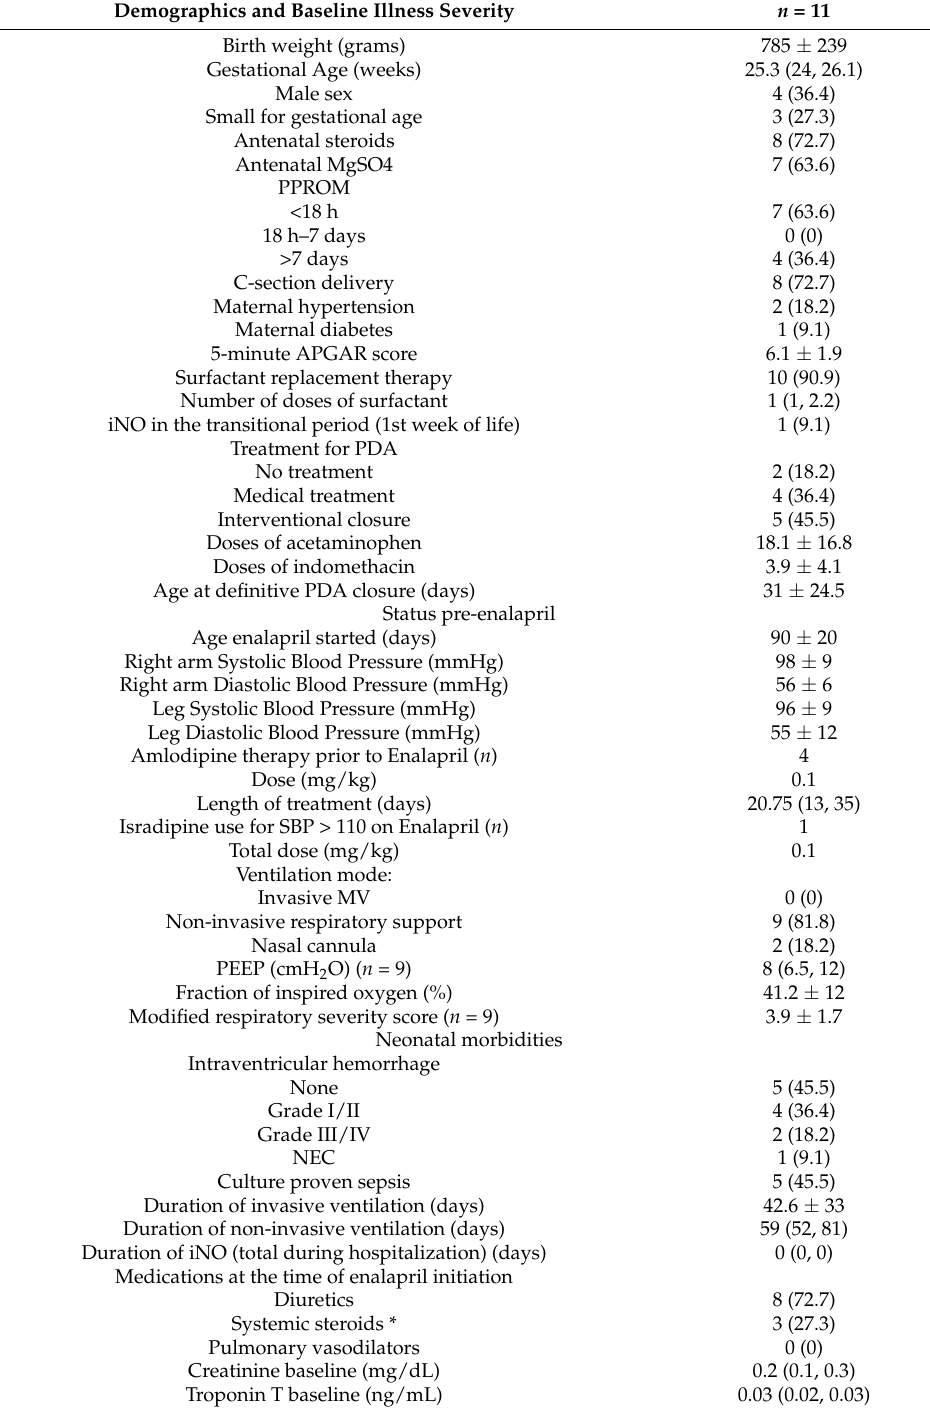
Table 1. Demographics and baseline illness severity in patients who received enalapril